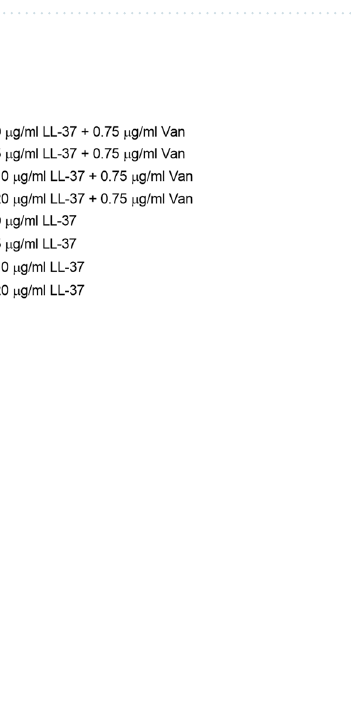
Figure 1. LL-37 influences vancomycin susceptibility of S. aureus . Exponential phase S. aureus FPR3757 cultures were pretreated with 0, 5, 10, 20 and 40 μg/ml LL-37 for 1 h before spotting serial fourfold dilutions on MH agar containing increasing concentrations of vancomycin.